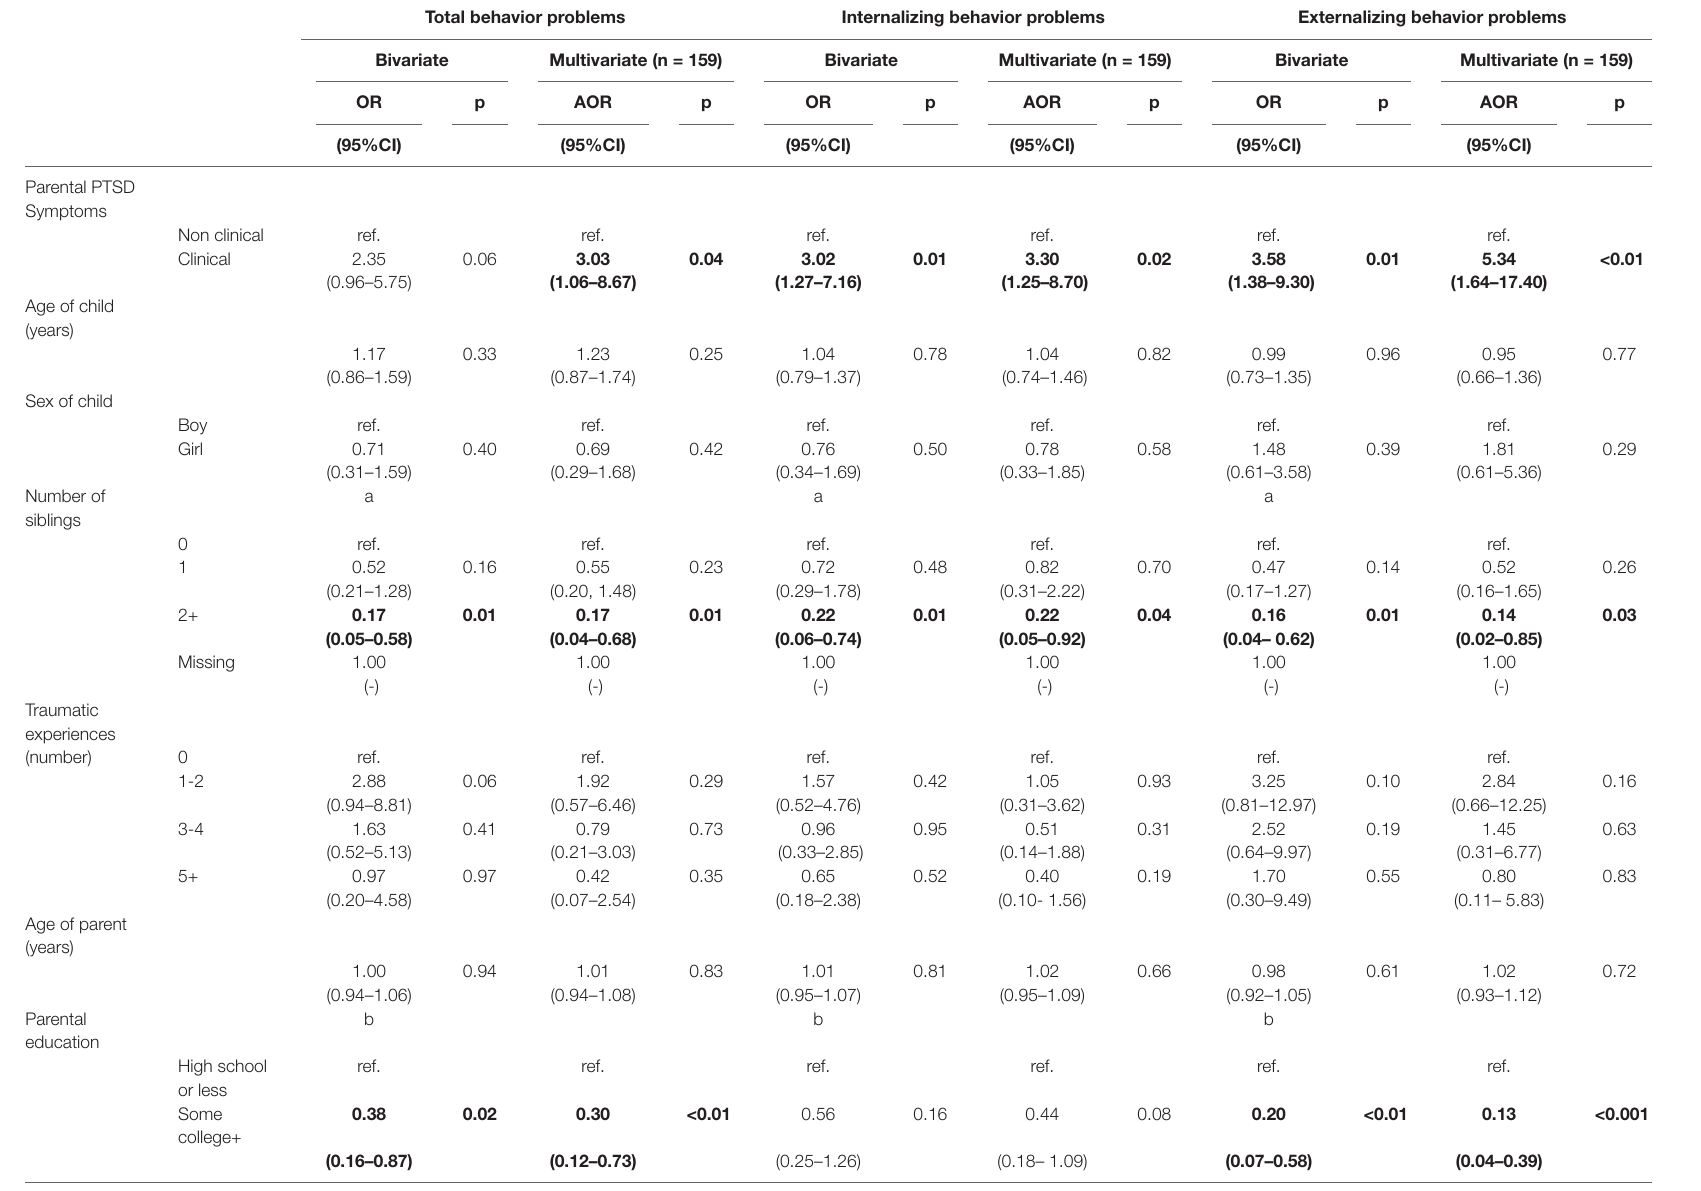
TABLE 4 | Association between parental PTSD symptoms and children’s behavioral problem in